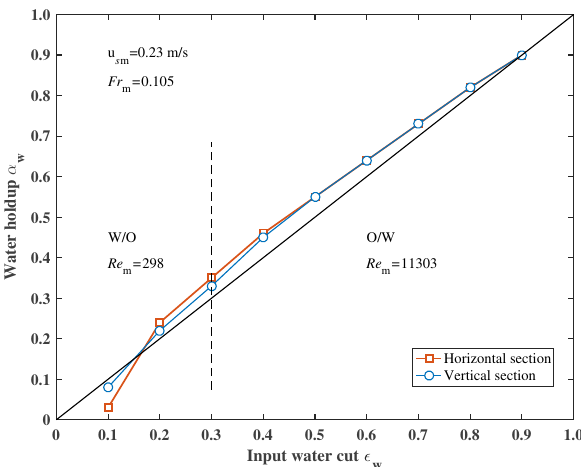
Figure 8. Average water holdup over input water cut at u s m = 0.23 m/s.